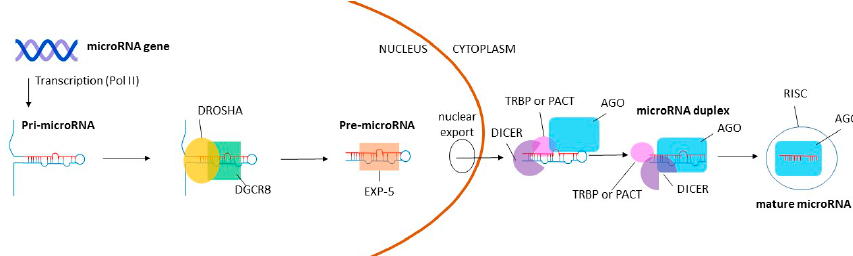
Figure 1. Basic pathway for miRNA biogenesis. Pri-miRNA is transcribed from a miRNA gene by RNA polymerase II (Pol II). DROSHA and DiGeorge syndrome critical region gene 8 (DGCR8) then